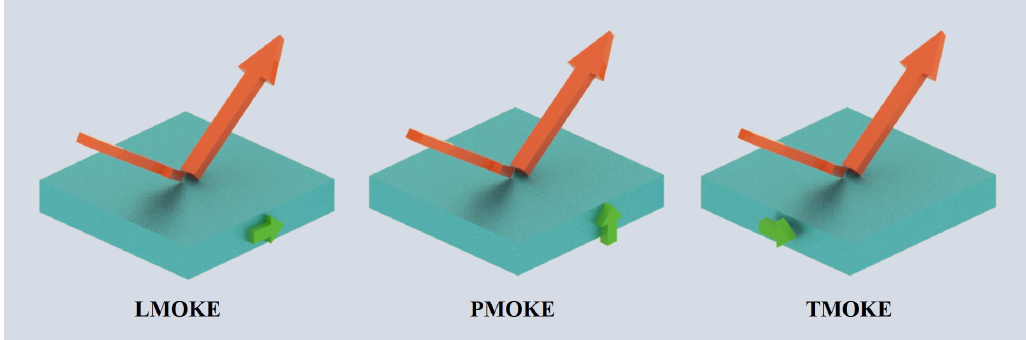
Figure 2. Schematic diagram of the magneto-optical Kerr effect in three different directions. In isotropic layers: